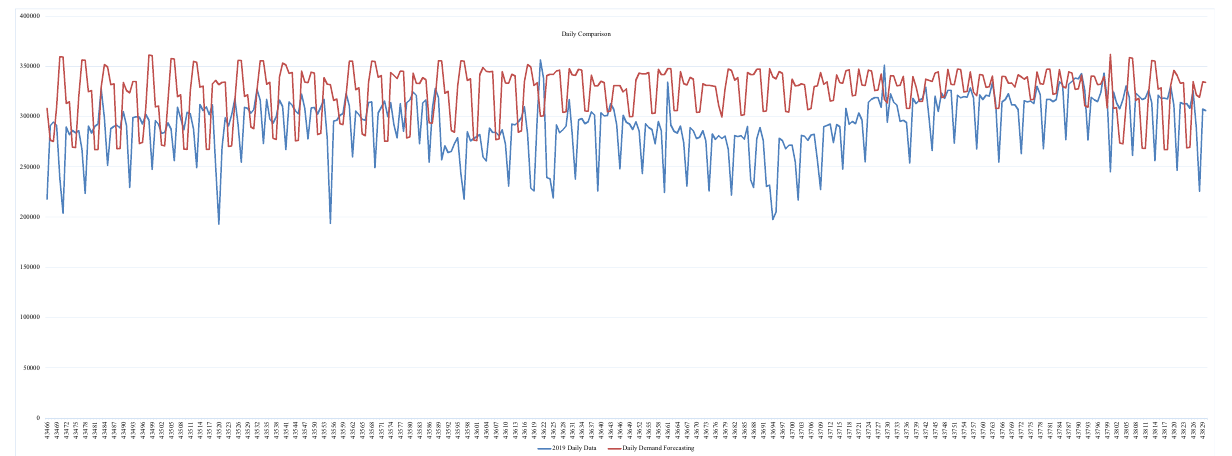
Figure 8: Comparison of daily test data and demand forecast with ANN of Yenikap ı